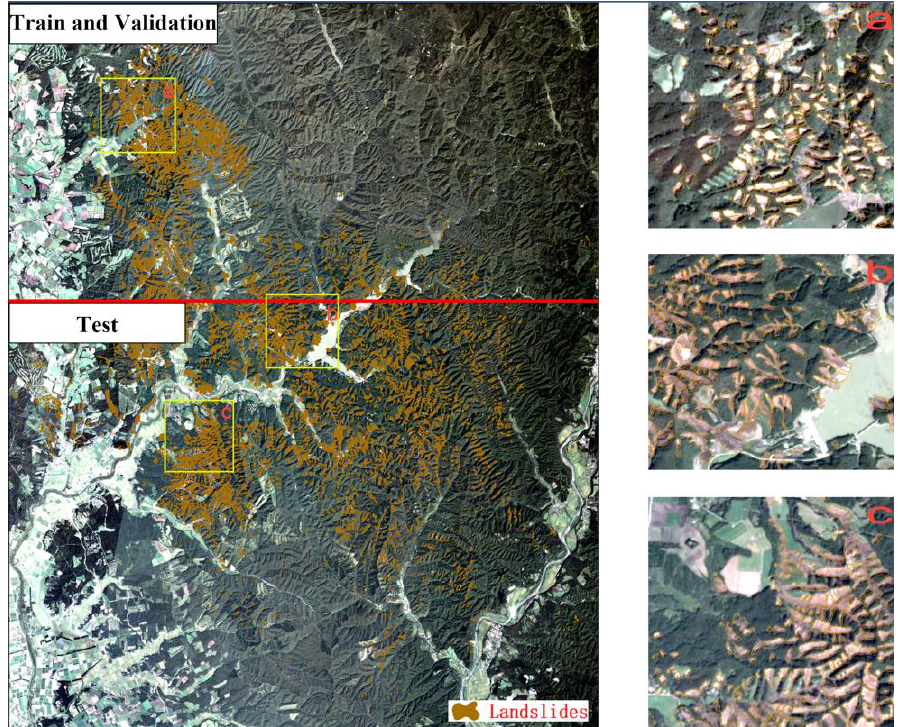
Figure 2. Map showing landslides identified by manual visual interpretation based on ArcMap. Brown polygons are the boundaries of individual landslides. The upper (left) of the red line represents the training and validation data, and the lower (left) represents the prediction data. ( a – c ) shows the specific ranges of landslides .